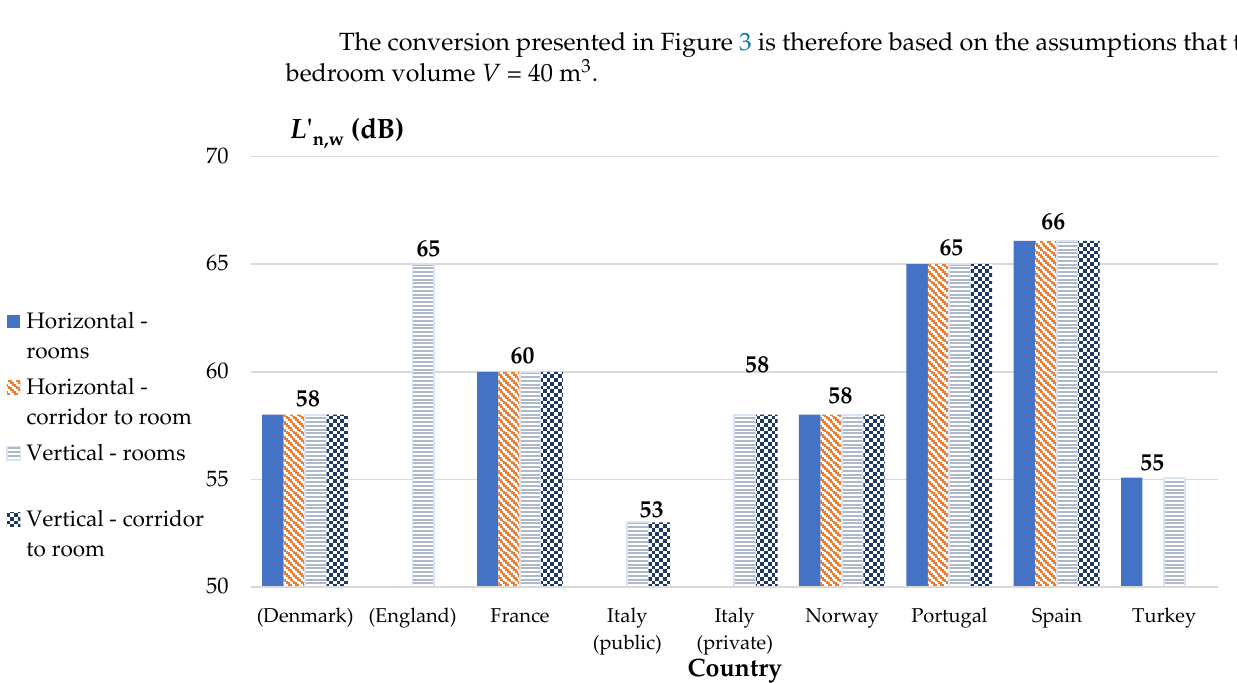
Figure 2. Comparison between limit values for airborne sound insulation between bedrooms and between bedrooms and corridors.